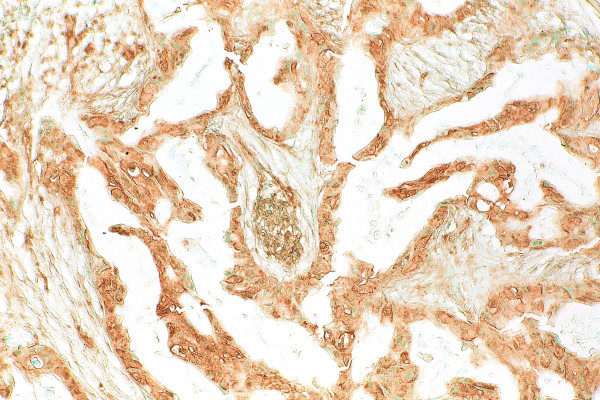
well differentiated adenocarcinoma: ILK protein was localized in both cytoplasms and nuclei. (Magnification, ×40 (Figure 1), ×16 (Figure 2), and ×40 (Figure 3)).